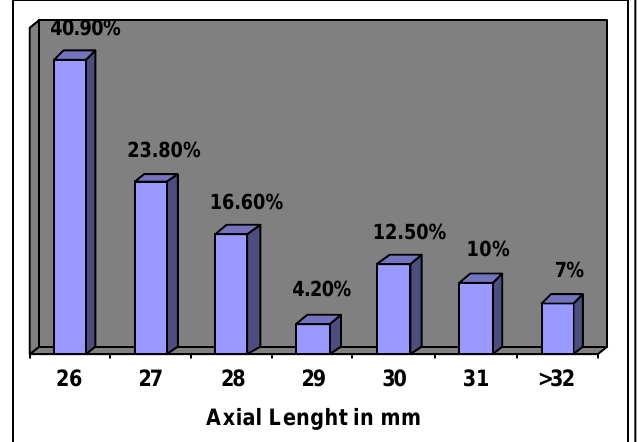
Fig. 1 : Prevalence of lattice degeneration by Celorio and Pruett.